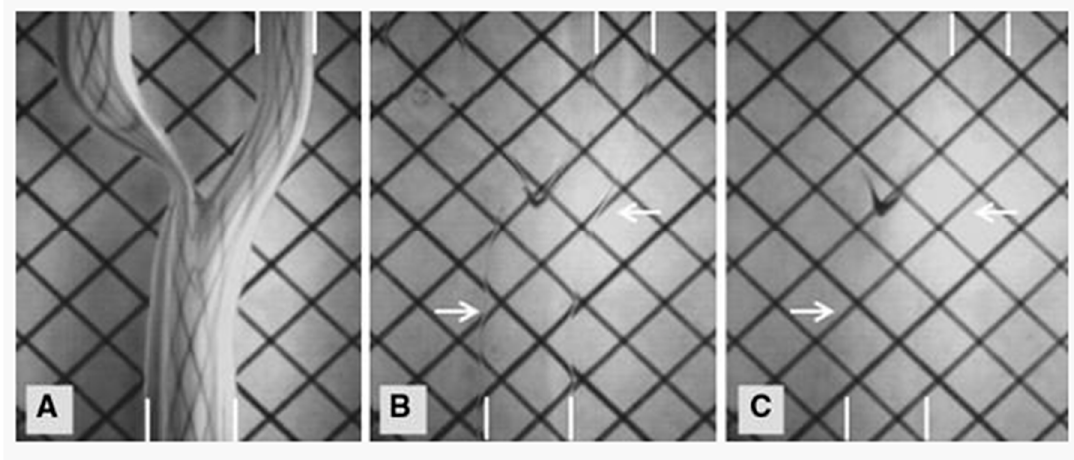
Figure 5. ( A ) The phantom is empty and has the refractive index of air. ( B ) The phantom contains “nearly-matched” fluid with minor optical distortions still present. ( C ) The phantom contains optimally matched fluid. (Courtesy Yousif et al.